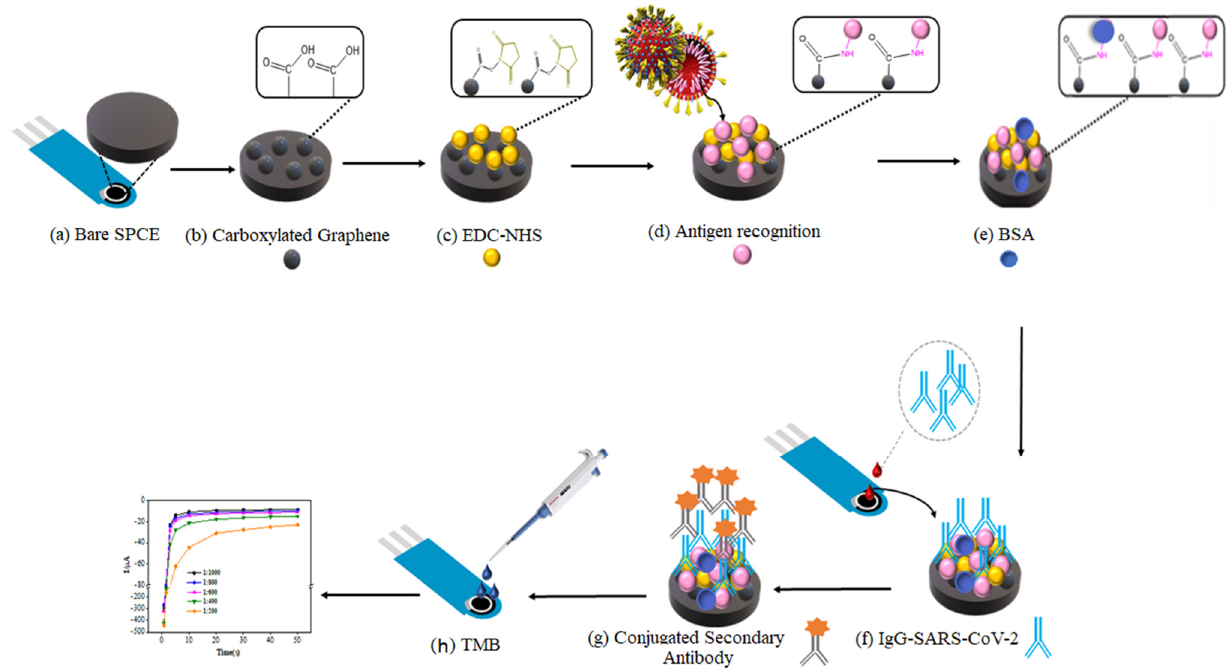
Scheme 1. Representation of the immunosensor assembly process and mechanism of indirect